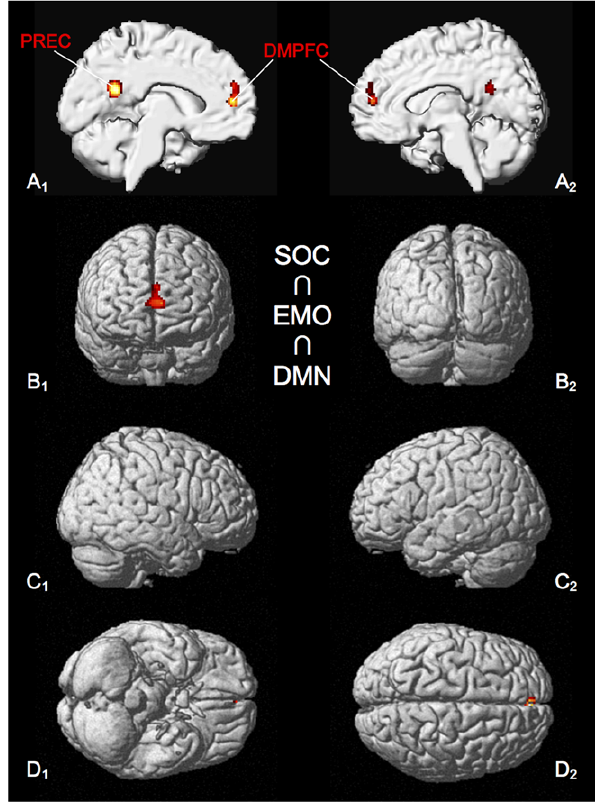
Figure 6. Significant results of the conjunction analysis of SOC > EMO > DMN. All results are displayed on the left and right lateral surface view, the anterior/posterior and dorsal/ventral view of the MNI single subject template. DMPFC: dorso-medial prefrontal cortex, PREC: precuneus. doi:10.1371/journal.pone.0030920.g006 PLoS ONE |